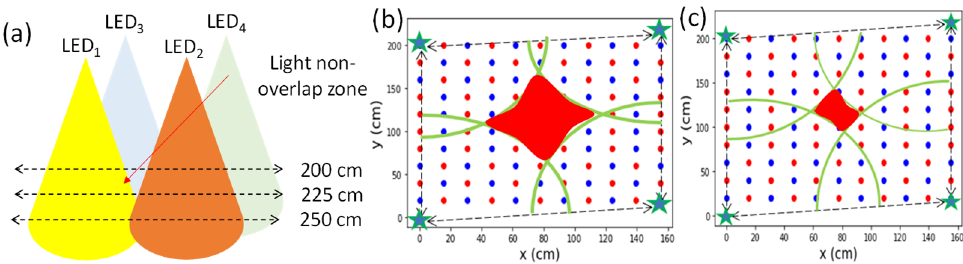
Figure 3. ( a ) Illustration of light non-overlap zone produced by the 4 LEDs. Top views of light non-overlap zone at Rx plane ( b ) 200 cm and ( c ) 225 cm.